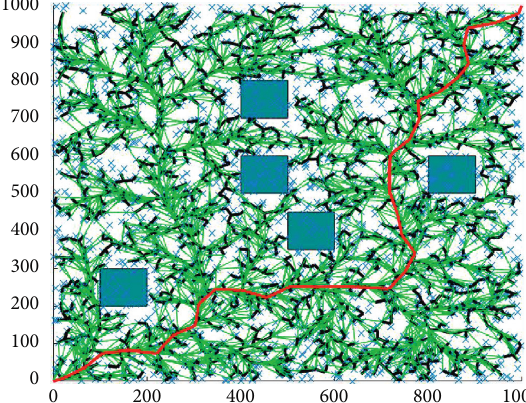
Figure 10: The path planned by hybrid RRT.